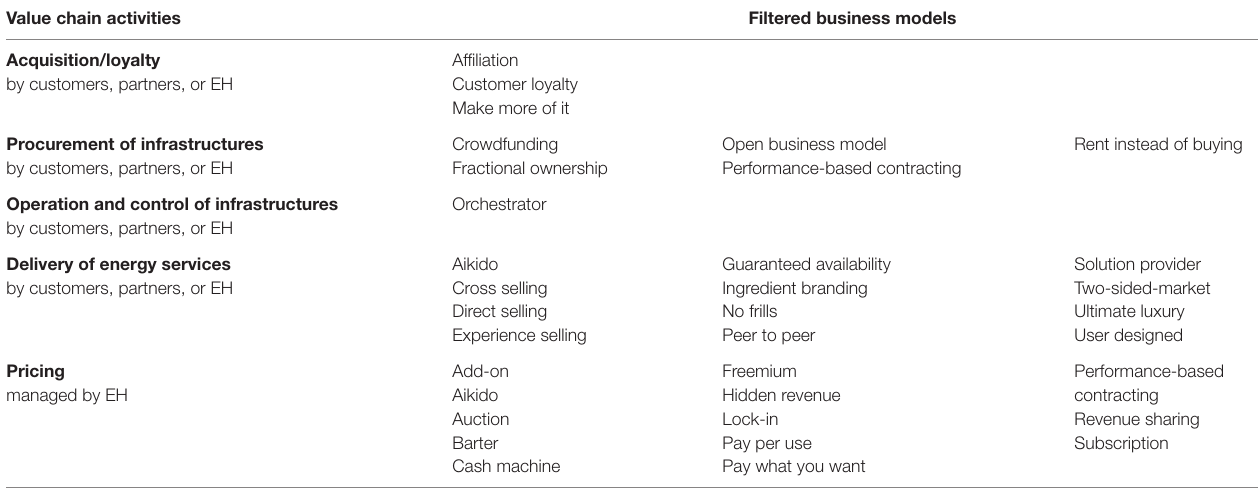
TaBle 1 | Filtered business model